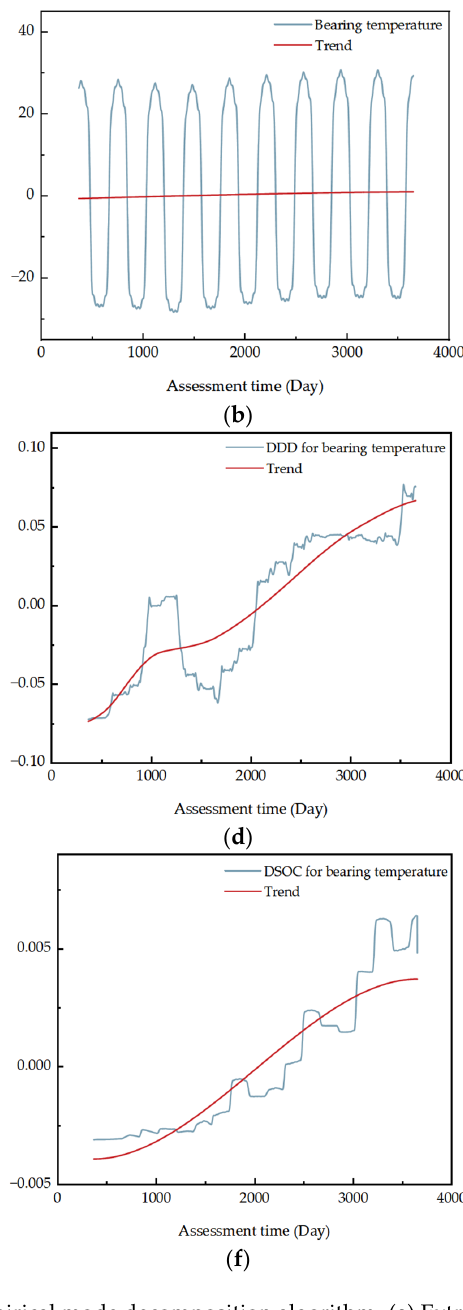
Figure 9. Trend extraction based on empirical mode decomposition algorithm. ( a ) Extraction of the trend in shell temperature data. ( b ) Extraction of trend in bearing temperature data. ( c ) Extraction of the trend in data distribution deviations (DDD) of shell temperature data. ( d ) Extraction of the trend in data distribution deviations (DDD) of bearing temperature data. ( e ) Extraction of the trend in differences in the similarity of operational data changes (DSOC) of shell temperature data. ( f ) Extraction of the trend in differences in the similarity of operational data changes (DSOC) of bearing temperature data.